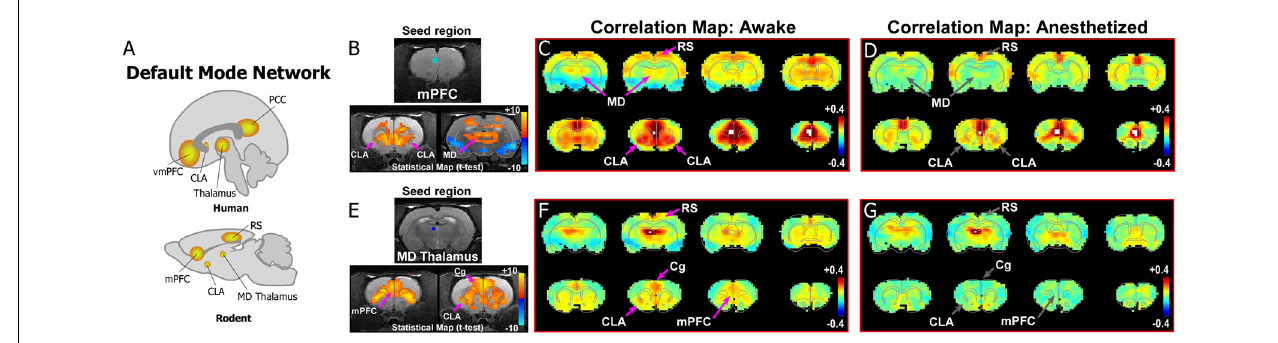
FIGURE 2 | Dynamic functional connectivity in the rodent homolog of the DMN. (A) Diagrams illustrating the human and rodent DMNs. (B–D) Analysis of resting-state fMRI (rs-fMRI) in awake and anesthetized rats for a medial prefrontal cortex (mPFC) seed shows the rodent homolog of the DMN in the awake state. (B) Top panel shows location of seed region in mPFC in a structural T1-MRI. Bottom panels show statistical maps comparing correlation strength in the awake and anesthetized states (voxelwise two-way t -test), indicating a significant reduction in the mPFC functional connectivity with CLA and mediodorsal (MD) thalamus. Hot colors show t -values for voxels with p < 0.05 (false discovery rate), with correlations that significantly decrease in the anesthetized state compared to awake. (C) Correlation maps from rs-fMRI with seed-based correlation analysis of mPFC in the awake state reveal strong connections to CLA, MD thalamus and retrosplenial cortex (RS). Color plot indicates scale of correlation strength: hot colors are correlated, cool colors are anti-correlated. (D) Correlation maps from rs-fMRI with seed-based analysis of mPFC in the anesthetized state show weaker functional connections with CLA and MD thalamus. (E–G) Similar analyses of an MD thalamus seed show strong functional connections with mPFC and CLA in the awake state that are significantly attenuated under isoflurane-induced loss of consciousness. Data modified with permission from Smith et al. (2017).